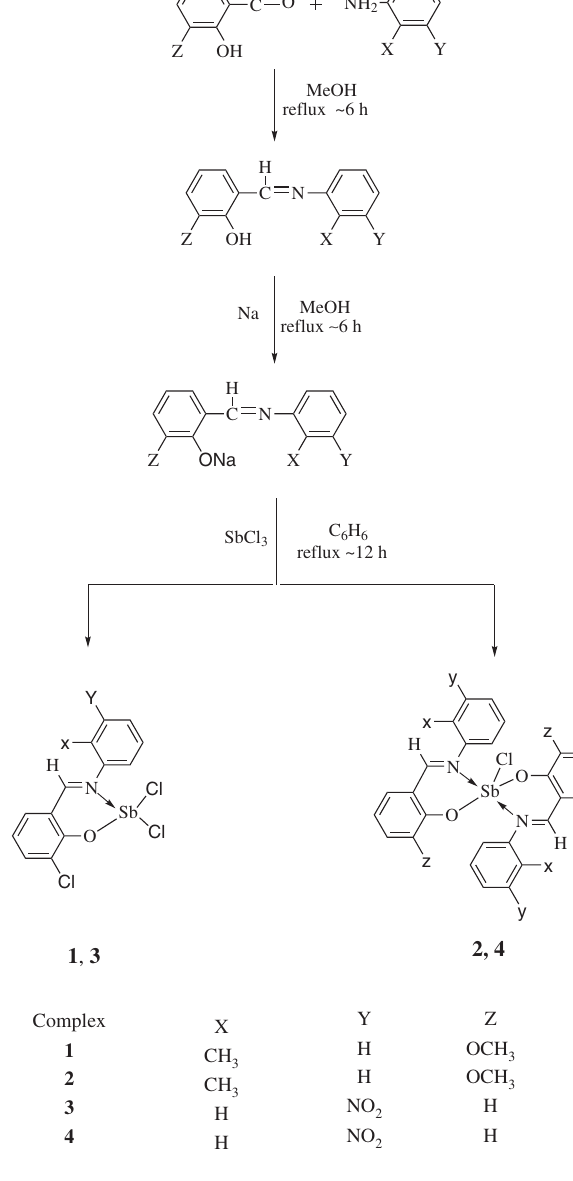
Table 3. A comparison of 1 H NMR spectra of ligand with metal complexes can lead to the following conclusions: